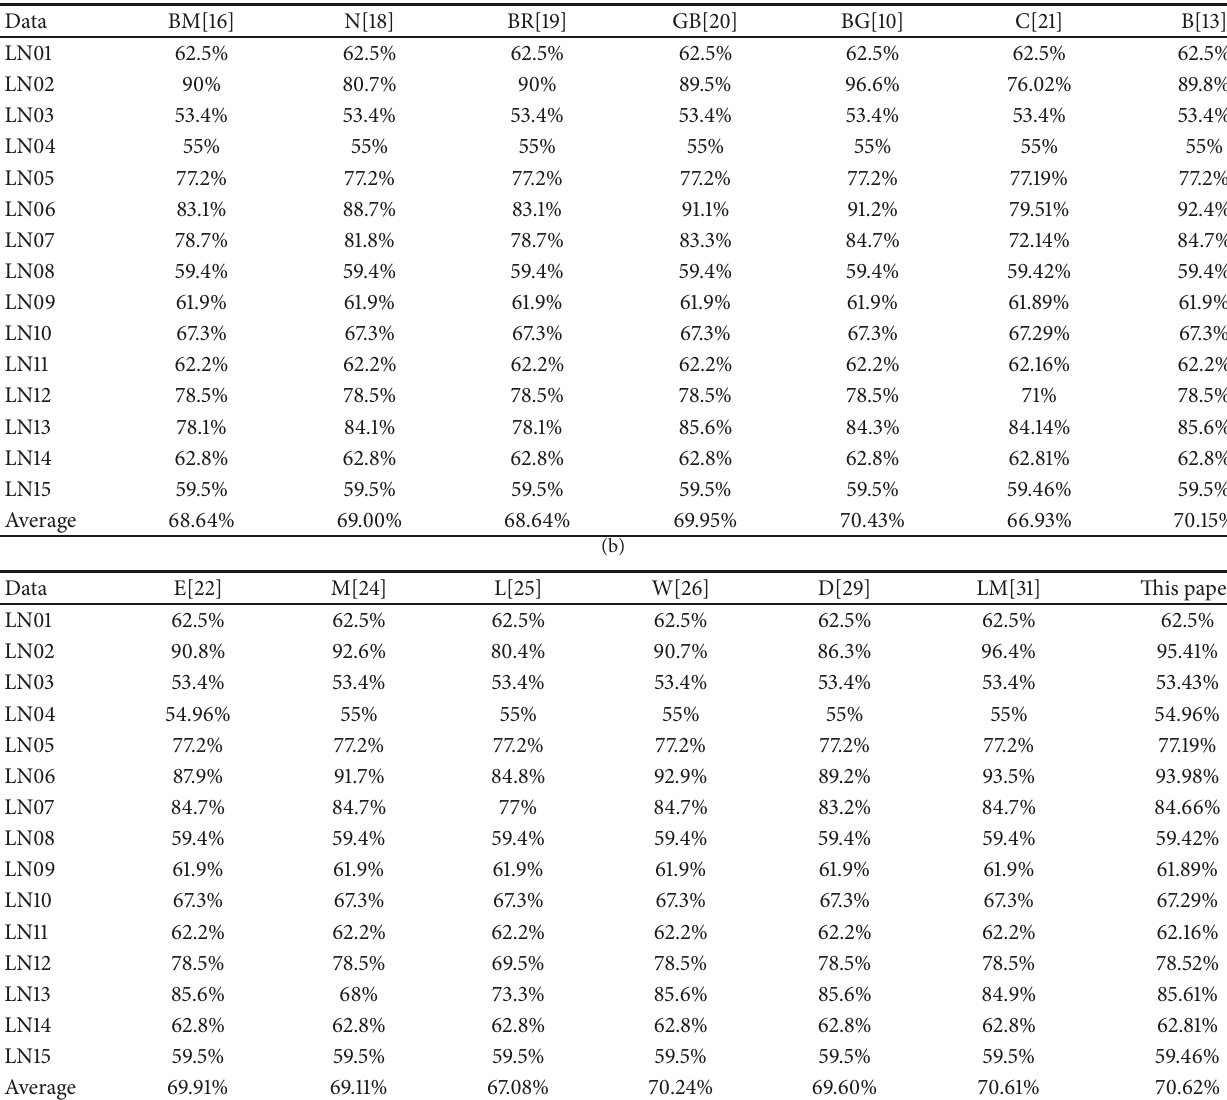
Table 5: Table of space utilization.